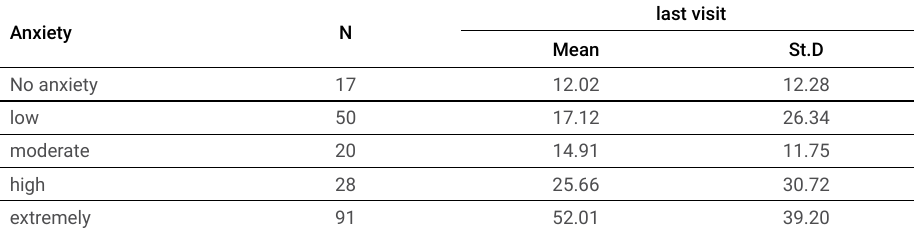
Table 4. The mean and standard deviation of the last visit to the dentist (month) at several levels of anxiety Anxiety